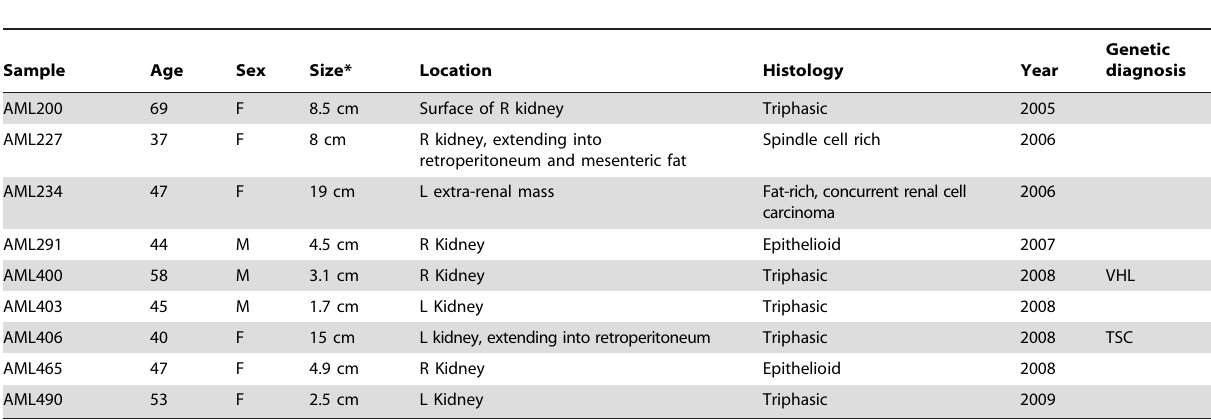
Table 1. Clinical features of patients with